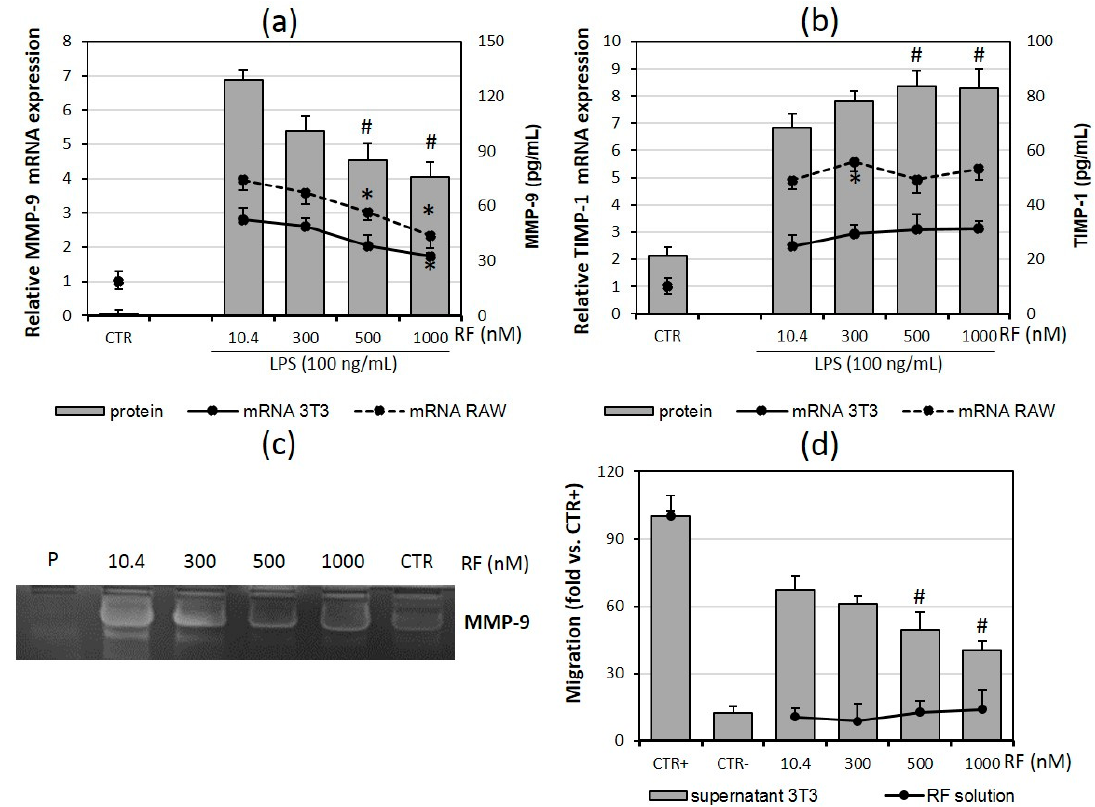
Figure 4. Effects of various riboflavin concentrations (10.4; 300; 500; 1000 nM) on LPS-induced metalloproteinase-9 (MMP-9; a , c ) and its inhibitor TIMP-1 ( b ) mRNA expression and release by adipocyte-macrophage co-cultures. Fully differentiated adipocytes 3T3 L1 and macrophages RAW 264.7 were cultured in 12-well dishes with inserts (0.4 µ m pore size) for 6 h (mRNA expression) or 24 h (cytokine release) after LPS stimulation (100 ng/mL). CTR − control group without LPS stimulation. ( d ) Macrophages RAW 264.7 migration to supernatants from adipocytes cultured in various riboflavin concentrations for 24 h and migration to various riboflavin concentrations (RF solution). Normal medium was used as a negative control (CTR − ), fMLP was used as a positive control (CTR+).